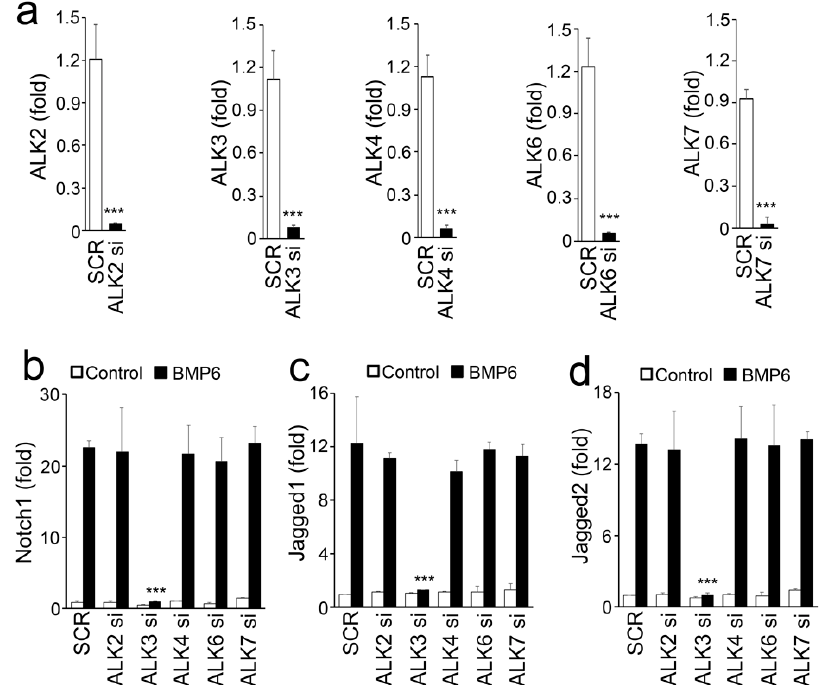
Figure 3. BMP6 induces Notch signaling through the activation of ALK3. ( a ) Expression of ALK2, 3, 4, 6, and 7 in HBMECs after transfection with individual siRNAs. ( b – d ) Expression of Notch1 ( b ), Jagged1 ( c ) and 2 ( d ) in BMP6-treated HBMECs after transfection with specific siRNAs (si) to ALK2, ALK3, ALK4, ALK6, or ALK7. *** p < 0.001. ALK3, ALK4, ALK6, or ALK7. *** p <